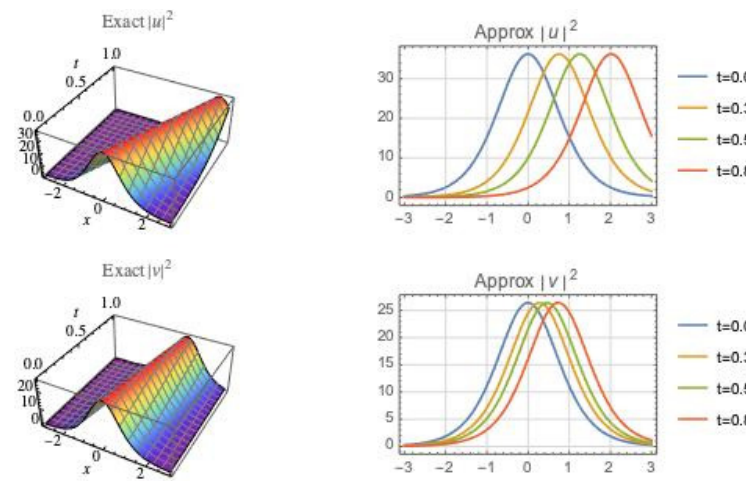
Figure 4. ( Above ) Three-dimensional illustrations of the numerical simulation and exact solution, and two-dimensional illustration of the approximation of |𝑢| (cid:2870) ; ( Below ) three-dimensional illustrations of the numerical simulation and exact solution, and two-dimensional illustration of the approximation of |𝑣| (cid:2870) for Case D. Table 4. Case D: Absolute error for different values of (cid:4666)𝑥,𝑡(cid:4667) considering 𝑁 (cid:3404) 15 steps.